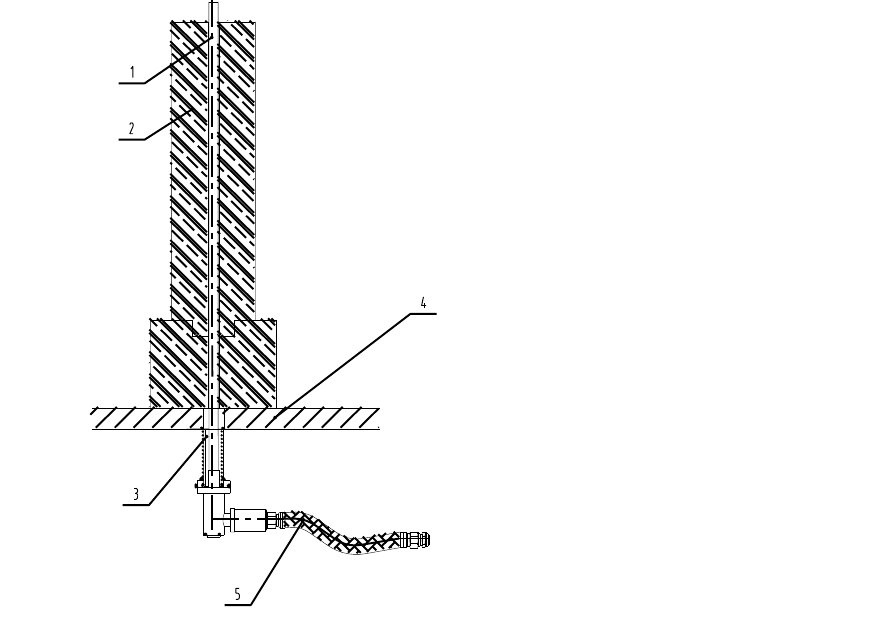
Figure 1. Schematic diagram of circular seam bottom-blowing gas supply element: 1 — steel pipe; 2 — brick; 3 — refractory mud; 4 – converter shell; 5 – metal hose. 2—brick; 3—refractory mud; 4–converter shell; 5–metal